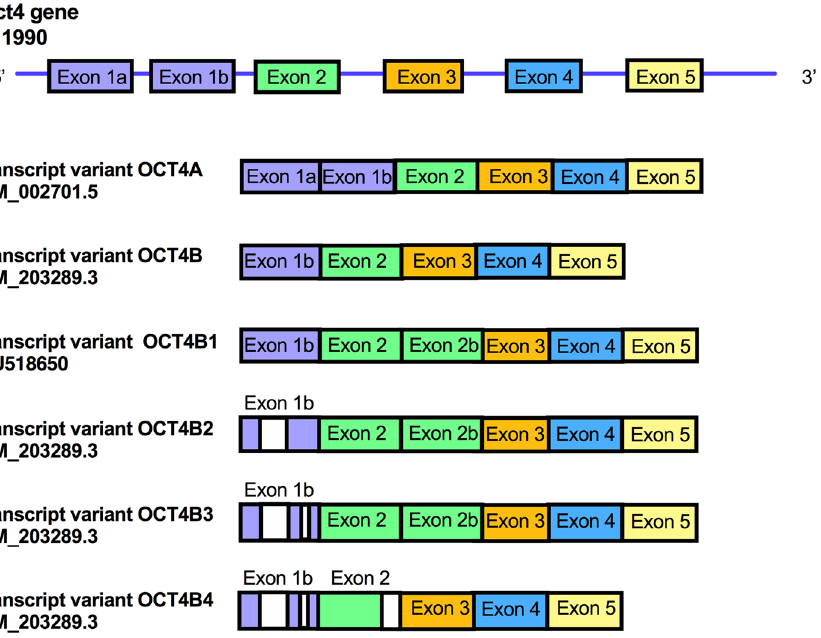
Figure 1. Schematic representation of the human OCT4 gene. List of transcript variants for OCT4. The OCT4A transcript variant is composed of exon 1a, and exons 2 to 5. The OCT4B transcript variant contains exon 1b, and exons 2, 3, 4 and 5. The OCT4B1 transcript variant contains exon 1b, exon 2, exon 2b, exon 3, 4 and 5. The OCT4B2 transcript variant is composed of exon 1b lacking a 630-nt fragment, 2, 2b, 3, 4 and 5. The OCT4B3 transcript variant is composed of exons 1b lacking a 207-nt fragment, exon 2, 2b, 3, 4 and 5. The OCTB4 transcript variant is composed of exon 1b, The OCT4B transcript variant contains exon 1b, exon 2 lacking a 28-nt fragment, exons 3, 4 and